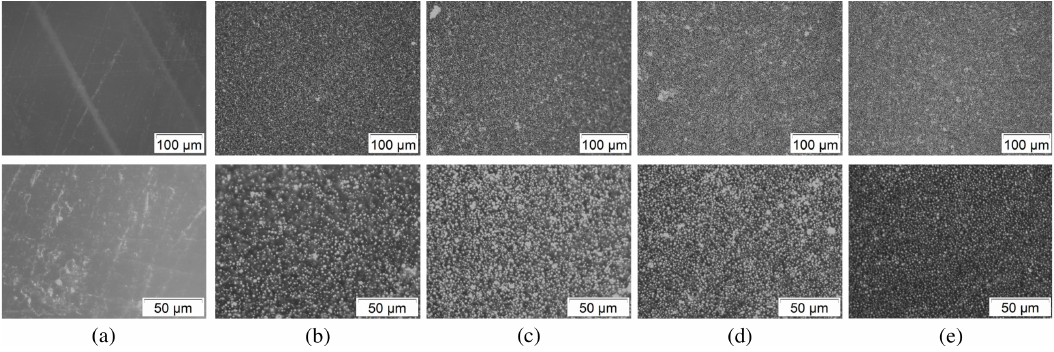
Figure 3. Microscopy images test sample cross-sections at ( top ) 20 × and ( bottom ) 50 × zoom. ( a ) Pure ABS, ( b ) 10vol. %, ( c ) 20vol. %, ( d ) 30vol. %; and ( e ) 40vol.